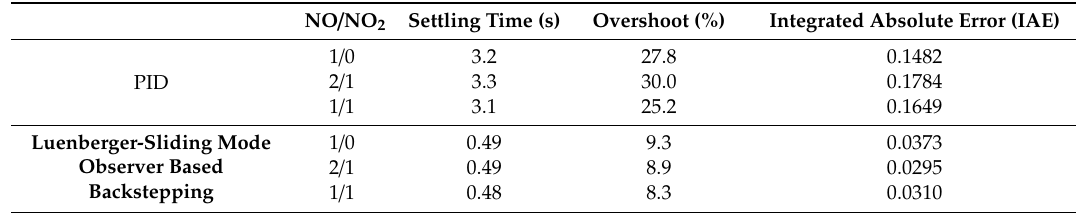
Table 6. Control performance of the two control